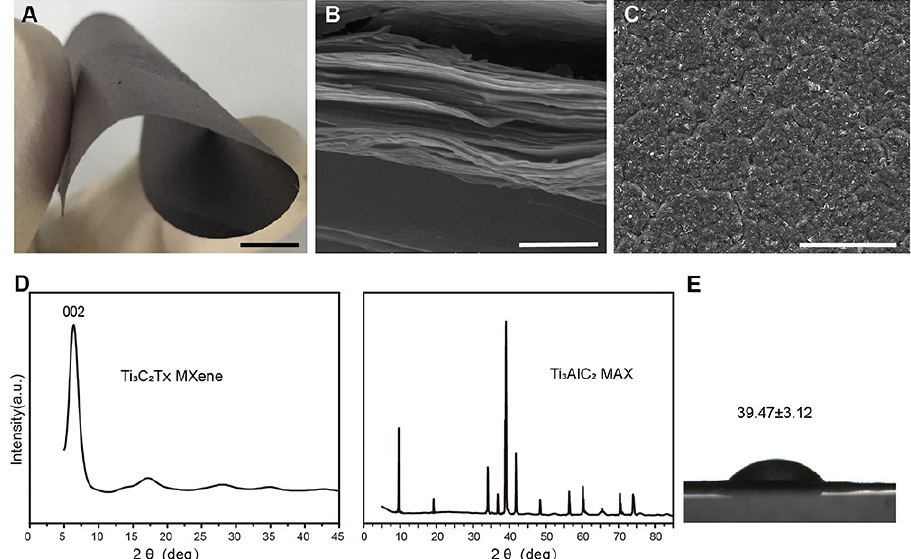
Figure 10. Multilayered Ti3C2Tx MXene film characterization. ( A ) Photograph of the MXene film, which is flexible and free-standing. ( B ) SEM picture of a cross-section of MXene sheets, scale bars: 5 mm, 1 μ m. ( C ) SEM picture of the surface of MXene films. Scale bars are 50 μ m long. ( D ) Ti 3 C 2 T x MXene and Ti 3 AlC 2 MAX XRD patterns. ( E ) Water contact angles ( n = 3) on Ti 3 C 2 T x MXene films [96].